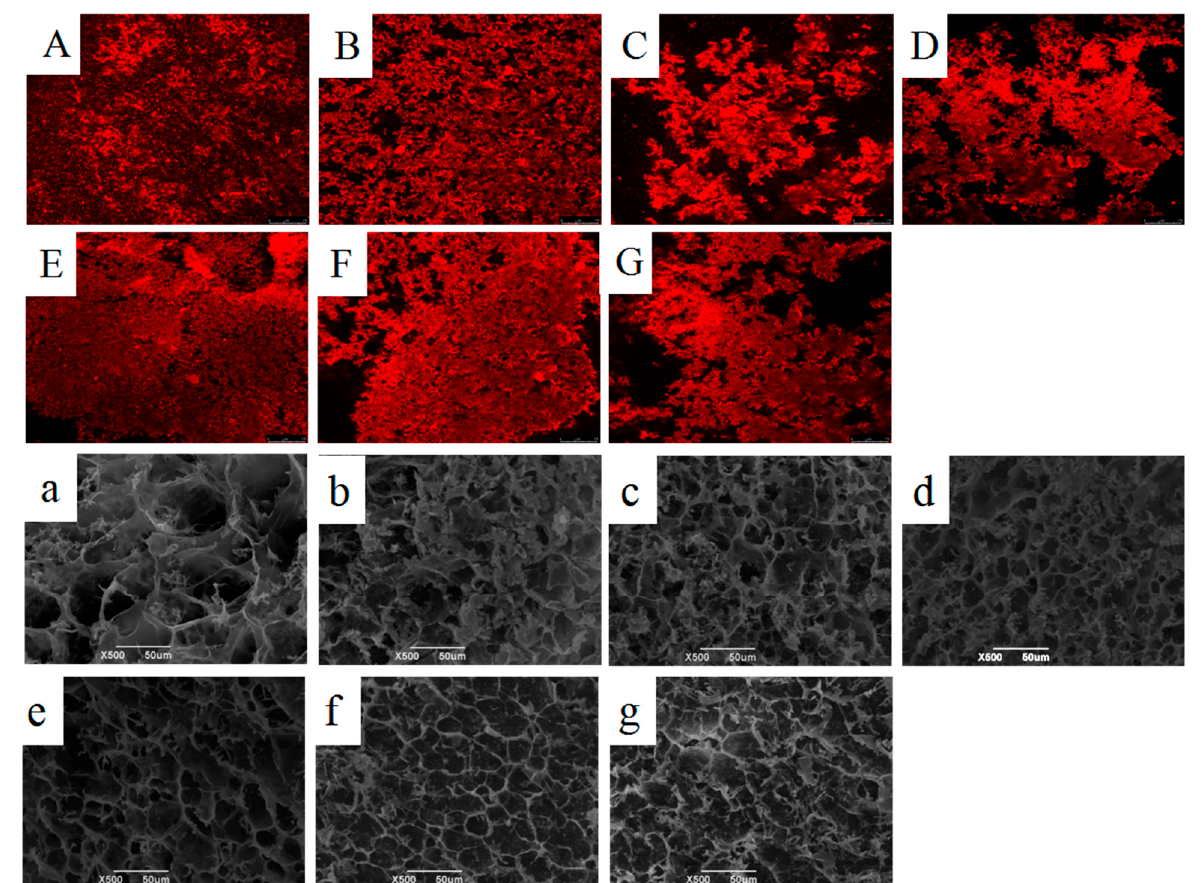
Figure 5. Effects of ultrasonic power on CLSM images ( A – G : WNPI/KC, U-200W, U-0W-TG, U-100W-TG, U-200W-TG, U-300W-TG and U-400W-TG) and SEM images ( a – g : WNPI/KC, U-200W, U-0W-TG, U-100W-TG, U-200W-TG, U-300W-TG and U-400W-TG) of WNPI-KC composite gels.